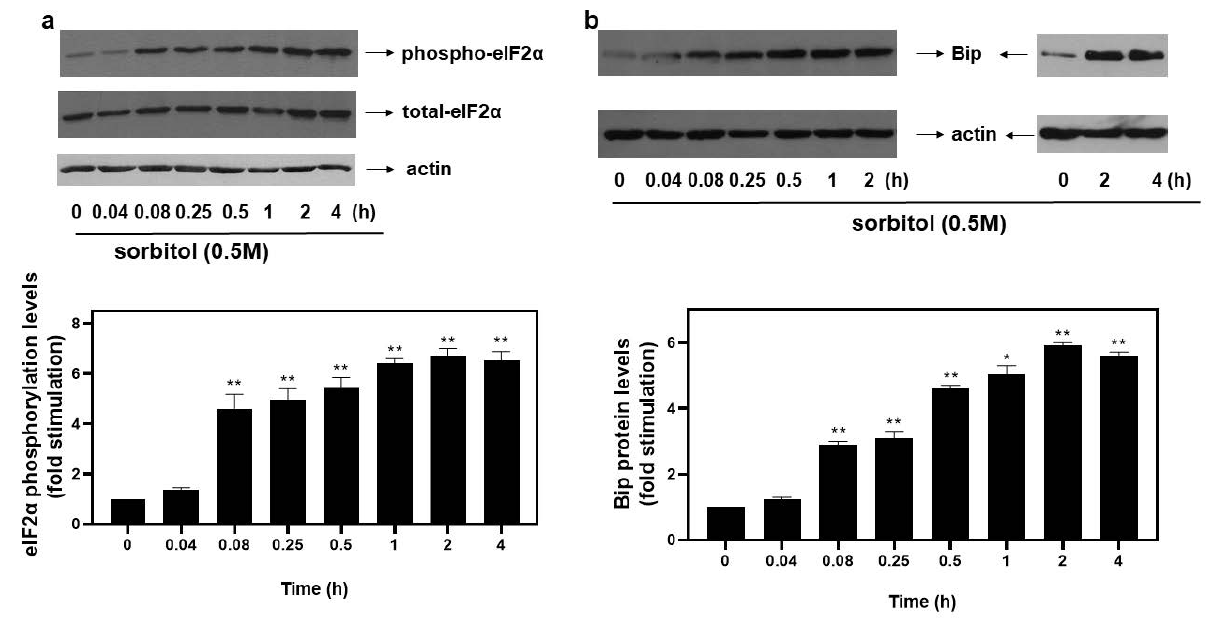
Figure 1. Kinetics of hyperosmotic-stress–induced phosphorylation of eIF2 α in H9c2 cardiac cells. H9c2 cells were exposed to 0.5 M sorbitol for the times indicated. Protein extracts (40 µ g/lane) were subjected to SDS-PAGE and immunoblotted with antibodies for phosphorylated eIF2 α (( a ), upper panel), total levels of eIF2 α (( a ) middle panel), total levels of BiP (( b ) upper panel) and actin (( a , b ) bot- tom panels). Western blots presented are representative of at least three independent experiments with overlapping results. Immunoreactive bands were quantified by scanning densitometry and plotted (( a , b ) respective graphs). Results are means ± SEM for at least three independent experiments. * p < 0.05, ** p < 0.01 compared to control